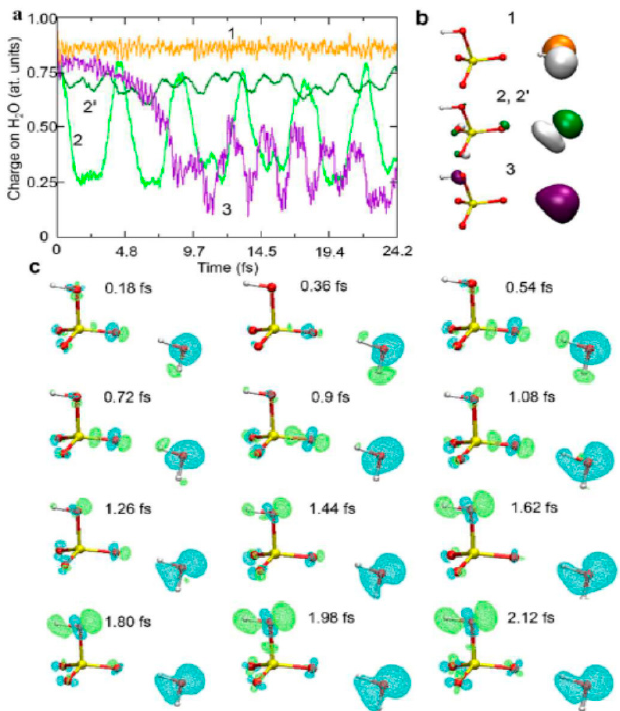
Figure 34. Electronic dynamics simulations. ( a ) Evolution of the charge of the water molecule hydrogen bonded to HSO 4- as a function of time after ionization took place, defined to be t = 0. Each plot (1, 2, 2 ′ and 3) corresponds to a different electronic dynamics generated by depopulating different valence MOs, the representations of which are shown in panel ( b ) for isosurfaces of ± 0.08 bohr − 3/2 . The two green curves (2 and 2 ′ ) correspond to ionization from the same MO but with different values of the hydrogen bond length between H 2 O and HSO 4 − , 1.8 and 2.4 Å, respectively, and ( c ) isosurfaces of the difference charge density with respect to the initial time for dynamics 2 and for different times spanning the first half period of charge migration. Blue and green isosurfaces indicate accumulation and depletion of electron density, respectively. Figure adapted from [136] with permission. Copyright 2017 The Royal Society of Chemistry.